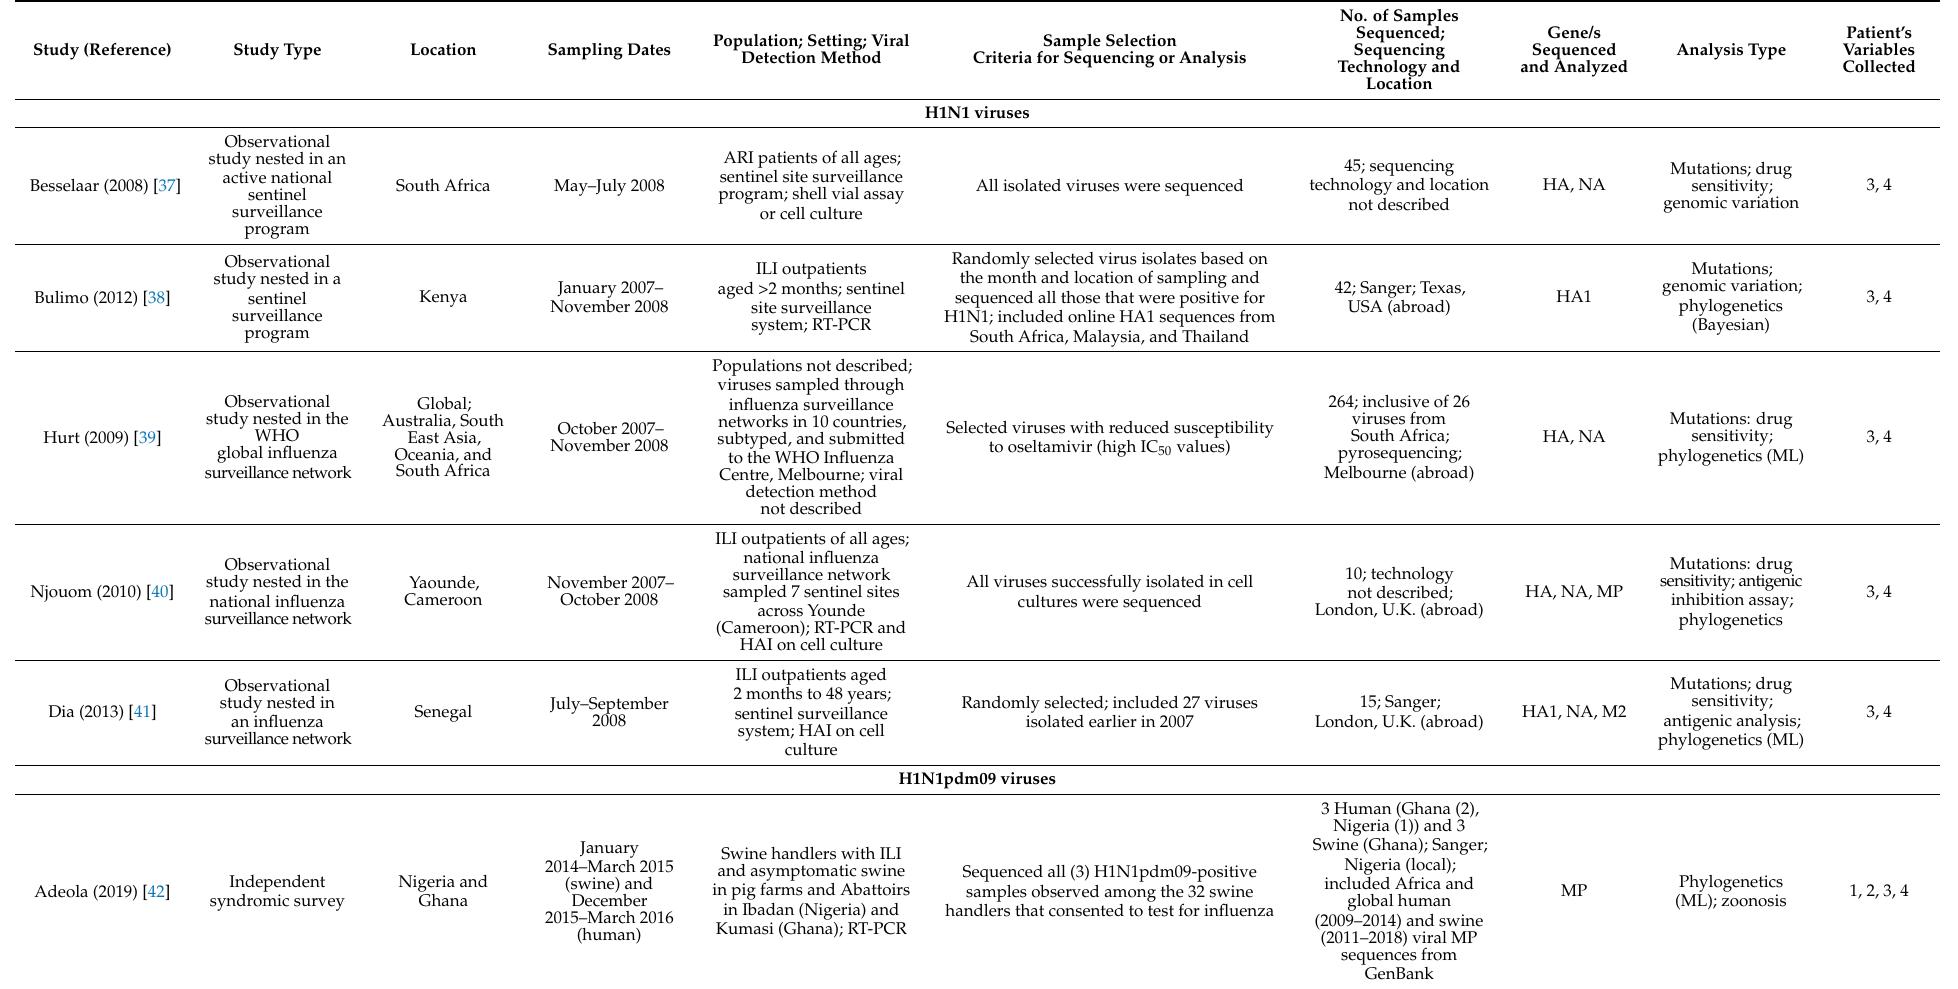
Table 1. Characteristics of eligible studies